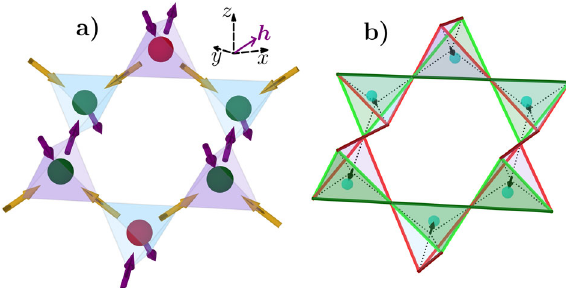
Fig. 4 Double-layered crystal of single monopoles. a Spins (drawn as arrows) and the resulting single monopole con fi guration (green and red spheres, indicating positive and negative charge). This magnetic structure has been measured under a moderate magnetic fi eld h ∣∣ [110] in Tb 2 Ti 2 O 7 25 . The spin lattice can be divided in: i- α − spins (painted purple) polarised by h ; ii- β − spins (yellow) perpendicular to h and building up antiferromagnetic β − chains (in-in/out-out). Monopoles linked by β -spins alternate in sign, forming β Q − chains of charge. α − spins decouple consecutive β Q − chains but, as proposed here, an effective nearest-neighbours attraction between like monopoles (Eq. (6) with γ < 0) can favour order such that the charge in two tetrahedra linked by an α − spin is the same. The main question our model is able to answer concerns the nature of the force that stabilises the single monopoles occupying each tetrahedron when the fi eld increases from zero. b Structural con fi guration for the O − 2 -ion near the centre of each tetrahedra. Through the magnetoelastic coupling, monopoles are stabilised by the displacement of the central oxygen (small cyan spheres) along 〈 111 〉 directions. These distortions (which should be compared with those proposed on Fig. 6 in ref. 25 decrease the exchange energy along the three bonds of the triangular face (painted green) approached by the O − 2 ions, favouring "three-in", or "three-out" con fi gurations in these triangles (see a)). The spins form "one-in/one-out" con fi gurations on the other bonds (painted red), where the exchange constant increases. The exchange constants along ± z (painted in slightly darker colours) are further modi fi ed by magnetostriction, which triggers the O − 2